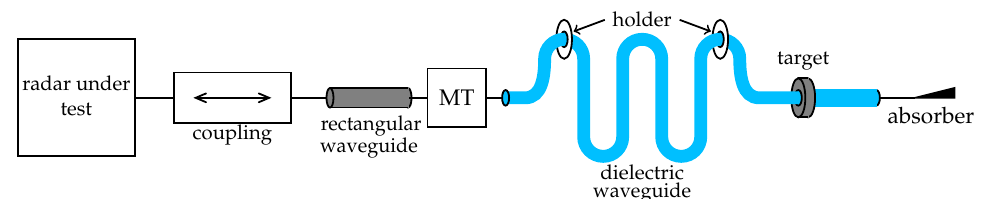
Figure 1. System concept of the radar target generator.